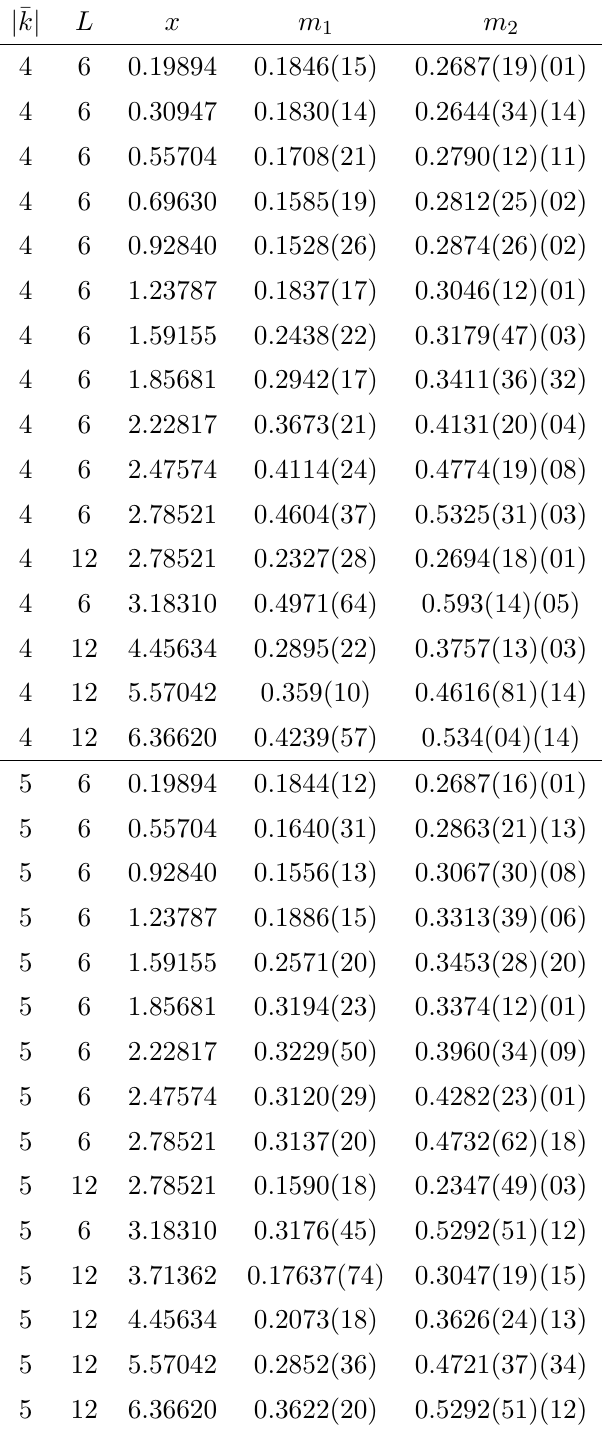
Table 23. Mass gap and next excited state energy (in lattice units) in the zero-electric (cid:13)ux scalar sector for SU(11) (continued).